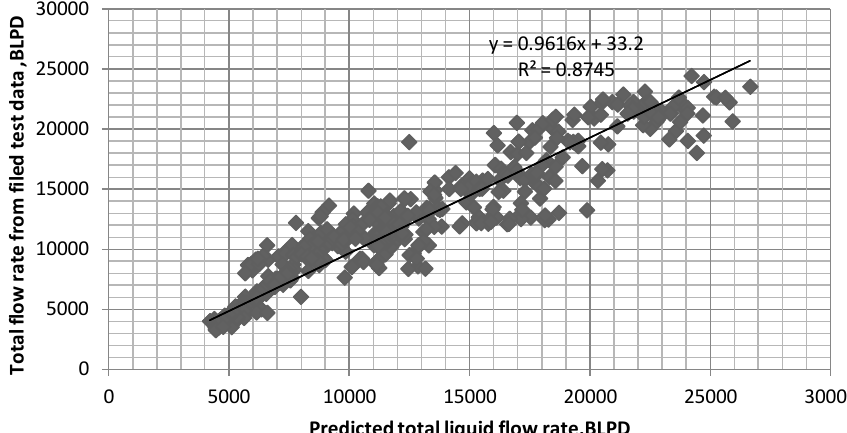
Figure 2. Predicted vs. measured flow rates for the second derived